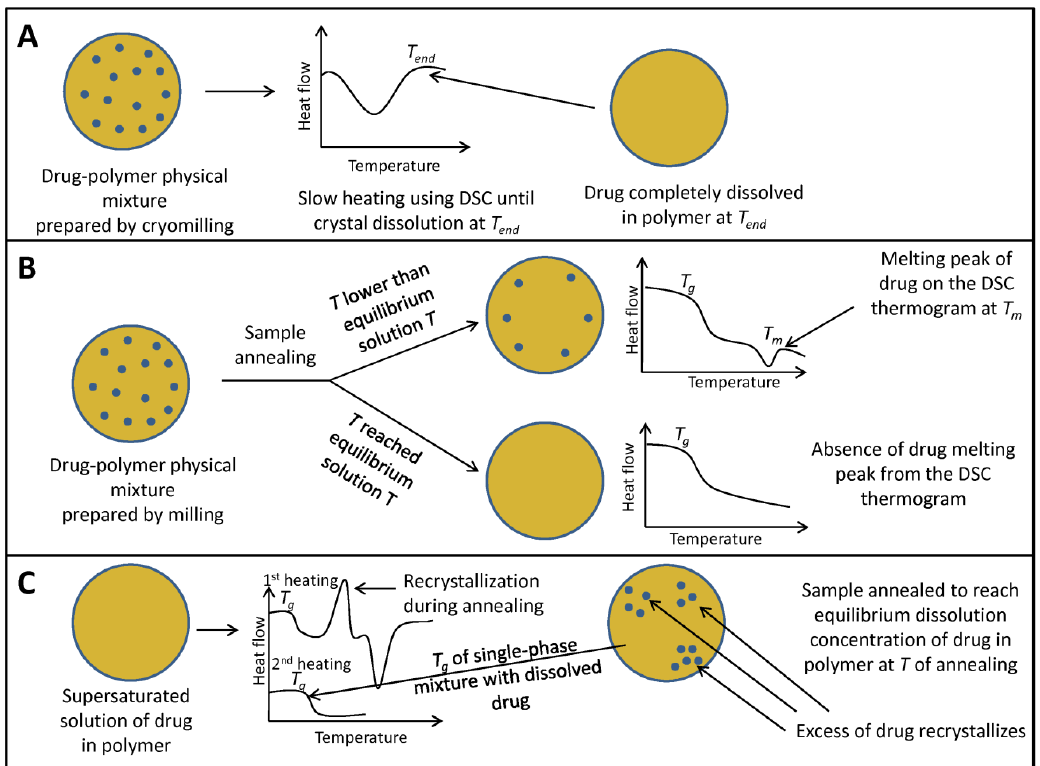
Figure 1. Schematic drawing of methods for the determination of drug solubility in polymer described by ( A ) Tao et al. [13], ( B ) Sun et al. [42], and ( C ) Mahieu et al. [43] ( T —temperature, T g —glass transition temperature, T end —end temperature of drug dissolution, T m —melting temperature).